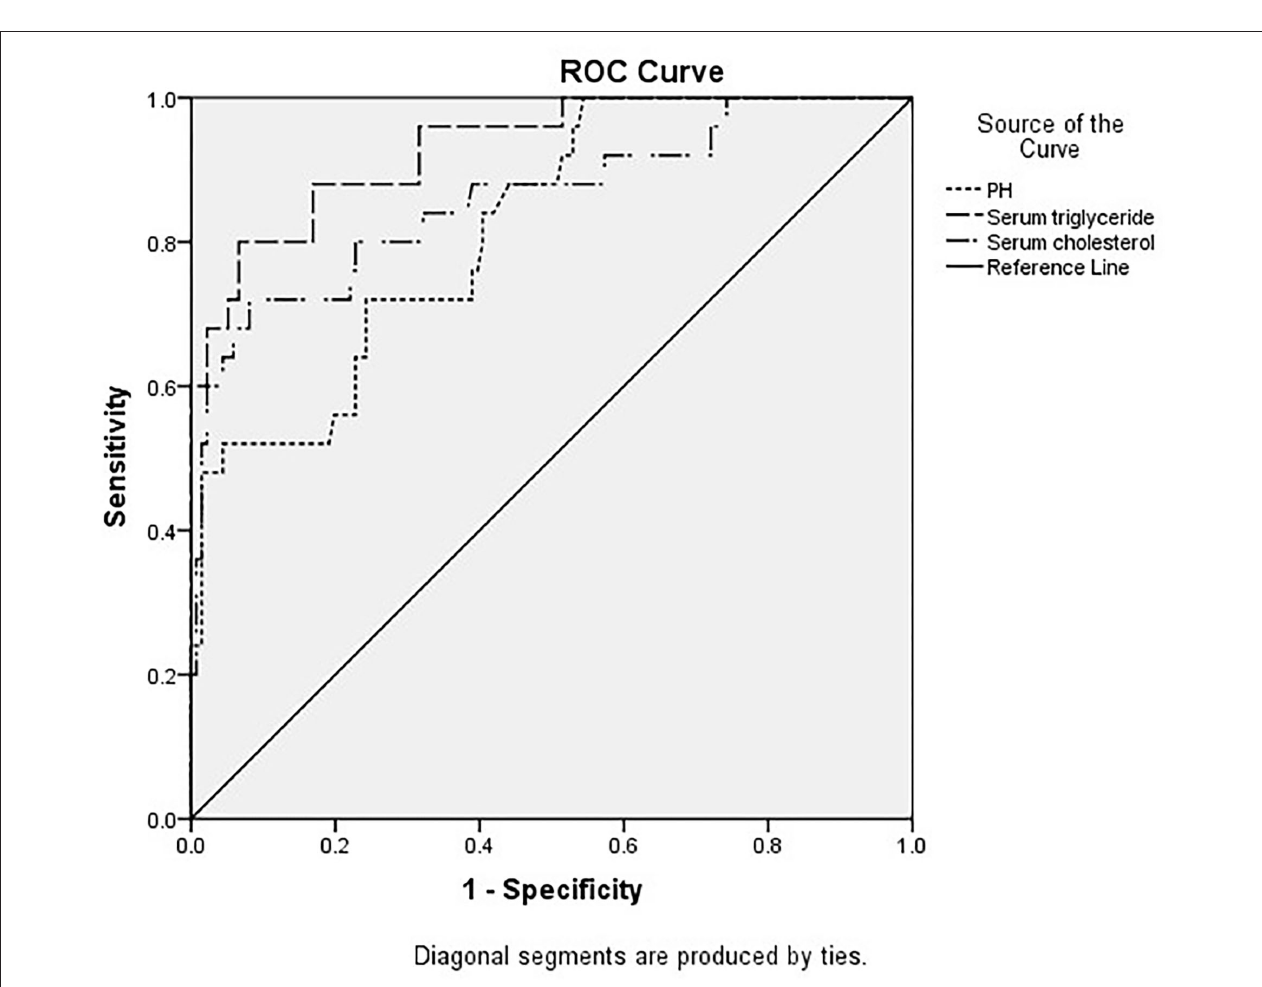
FIGURE 1 | Different indicators predict the receiver operating characteristic (ROC) curve of diabetic ketoacidosis (DKA) patients with acute pancreatitis (AP).